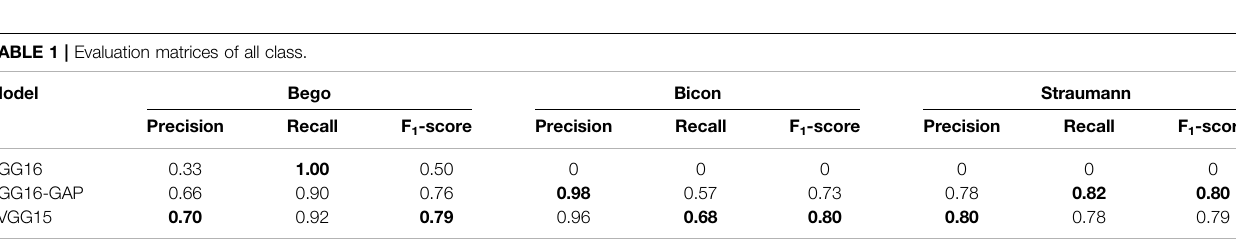
TABLE 1 | Evaluation matrices of all class.